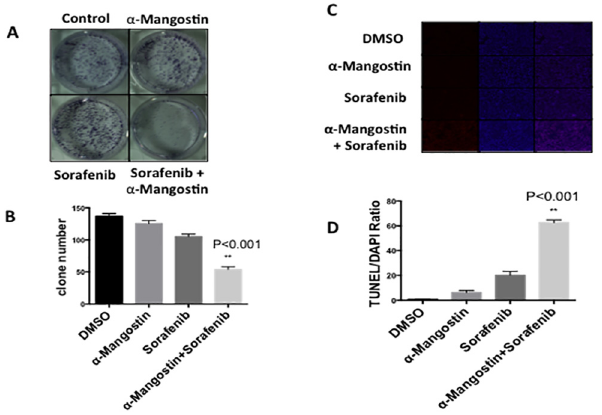
Fig 2. α -Mangostin activates Sorafenib induced apoptosis. A, Clonogenic survival assay was performed to examine the synergistic effect of the combination of Sorafenib and α -Mangostin on the survival of SK-MEL- 2 cells. Cell colonies ware stained in blue. B, Colony numbers were counted. The combination of Sorafenib and α -Mangostin significantly suppressed colony formation (p = 0.001). C, TUNEL staining detects cell apoptosis. Slices were cultured in medium containing Sorafenib (5 μ M), α -Mangostin (2 μ M) or their combination for 3 hours and stained for TUNEL (red) or 4 0 , 6-diamidino-2-phenylindole (DAPI; blue). Representative images of three independent experiments are shown. D. Apoptotic cells were counted. Student ’ s T-test showed that a significant increase of apoptotic cells appeared in the drug combinatorial treatment (p =